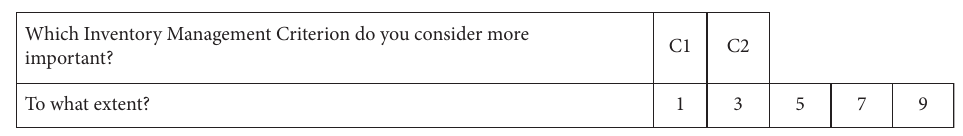
Figure 3: Sample of questionnaire used for comparison of criteria. Table 10: Multicriteria ABC Classification